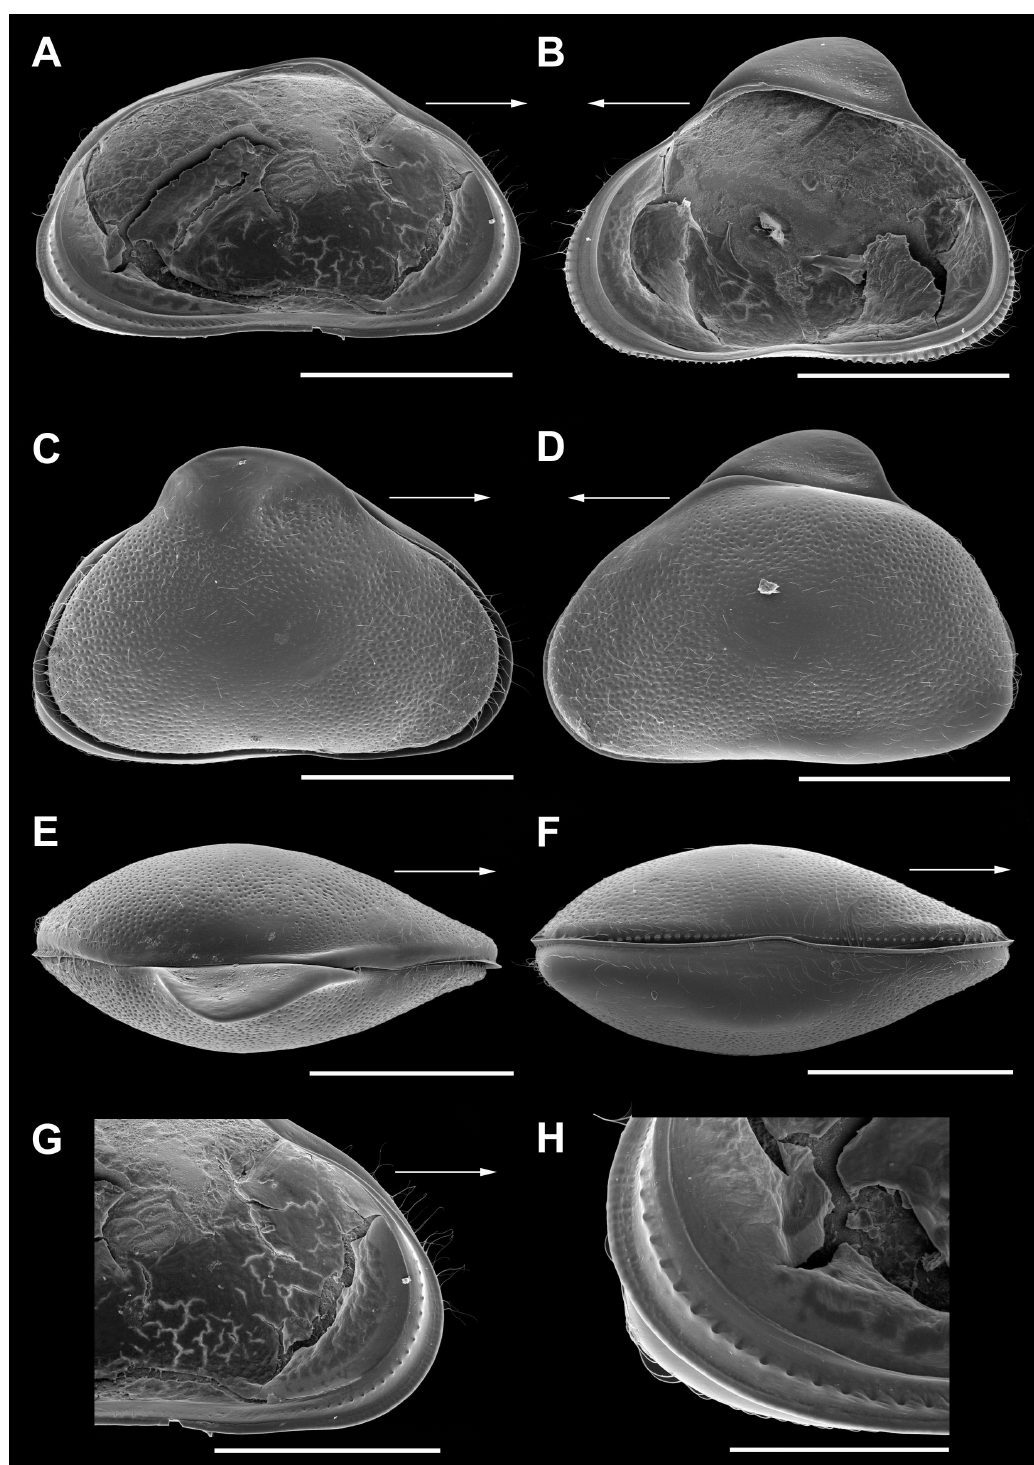
Fig. 2. Scanning Electron Microscope images of Cyprinotus drubea sp. nov., ♀♀. A . LVi (MNHN- IU-2019-784). B . RVi (MNHN-IU-2019-784). C . CpRL (MNHN-IU-2019-783). D . CpLL (RBINS- INV.156000/OC.3400). E . CpD (MNHN-IU-2019-782). F . CpV (RBINS-INV.156001/OC.3401). G . LVi, detail of anterior part (MNHN-IU-2019-784). H . LVi, detail of posterior part (MNHN- IU-2019-784). Arrows indicate anterior side. Scale bars: A–F = 500 µm; G = 400 µm; H = 200